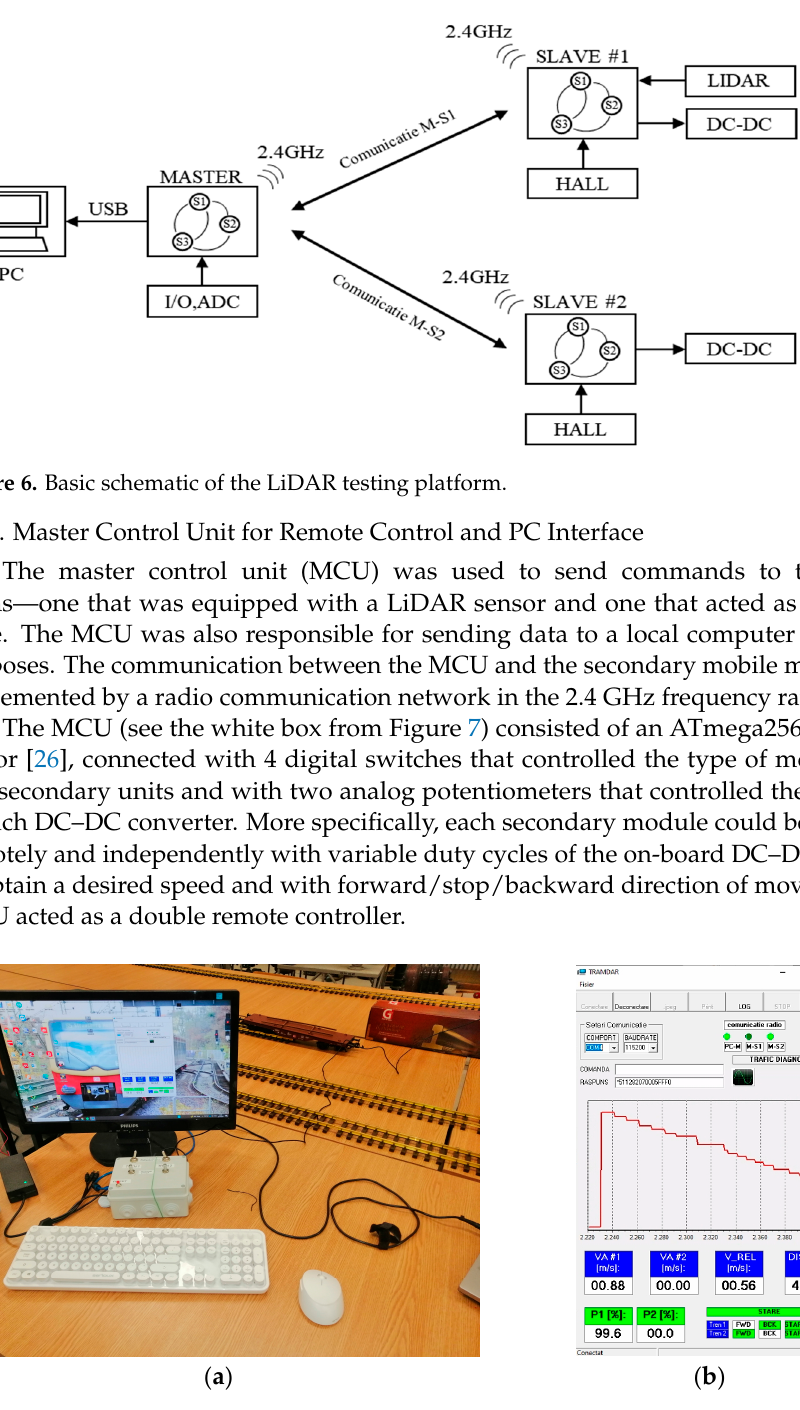
Figure 6. Basic schematic of the LiDAR testing platform.